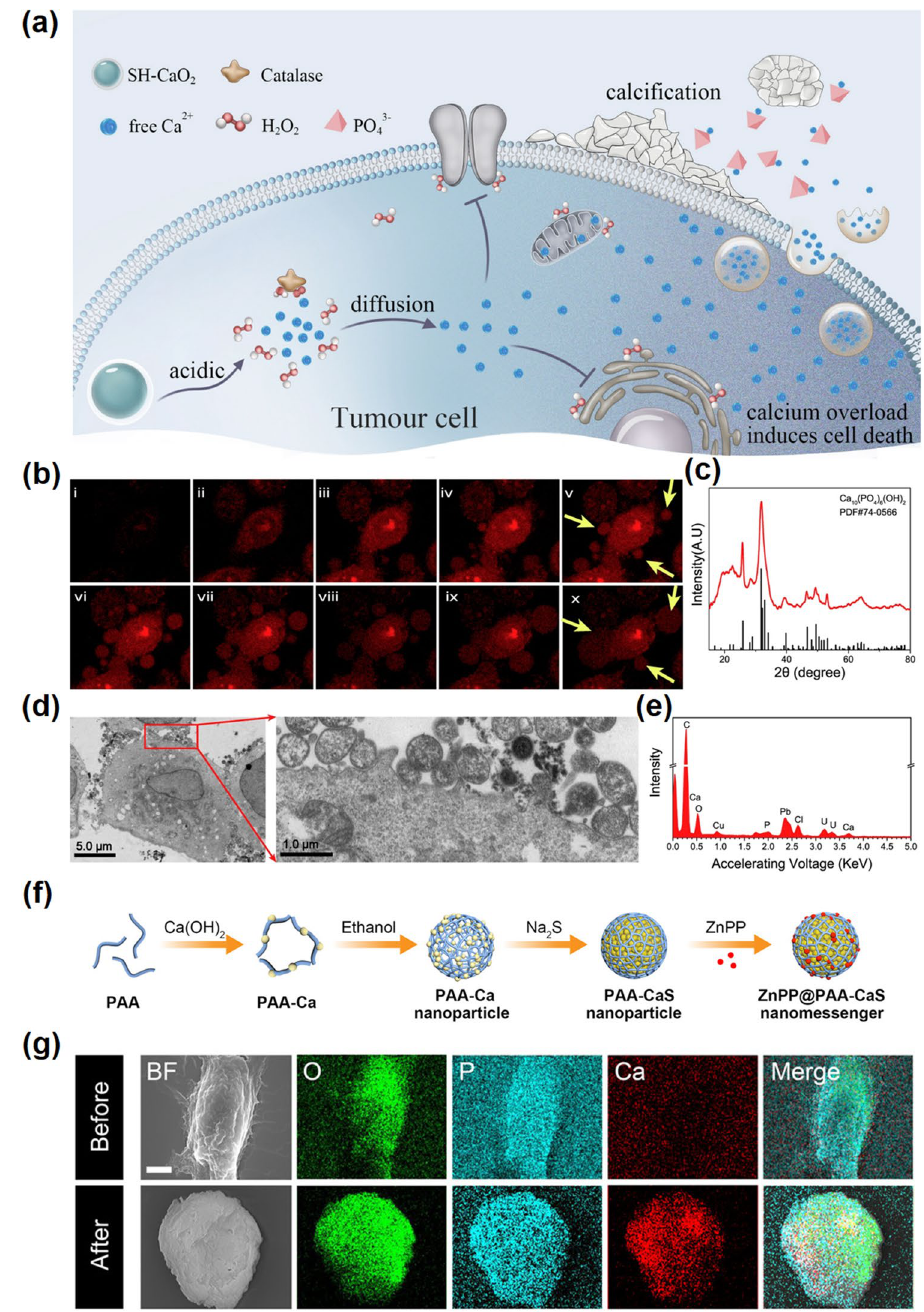
Fig. 13 Tumor calcification. a Schematic illustration of the function of SH-CaO 2 NPs in tumor cells. SH-CaO 2 NPs are decomposed to release Ca 2+ and H 2 O 2 molecules in TME. Low expression of CAT in cancer cells leads to accumulation of H 2 O 2 and imbalance of calcium transport pathways, which leads to efficient calcium overload in cells and induces cell death. Meanwhile, increased local Ca. 2+ concentration increases the possibility of tumor calcification. b The yellow arrow showed calcium-enriched small vesicles formation and exocytosis after SH-CaO 2 NPs treatment. c The XRD of the product collected by exocytosis of cells treated with SH-CaO 2 NPs. d Bio-TEM images of calcification vesicles. e EDS of the extracellular products treated with SH-CaO 2 NPs [28]. Copyright 2019, Elsevier. f Illustration of the synthetic procedure of a ZnPP@PAA-CaS nanomessenger. g Elemental mapping of 4T1 cells after ZnPP@PAA-CaS nanomessenger treatment [196]. Copyright 2021, American Chemical